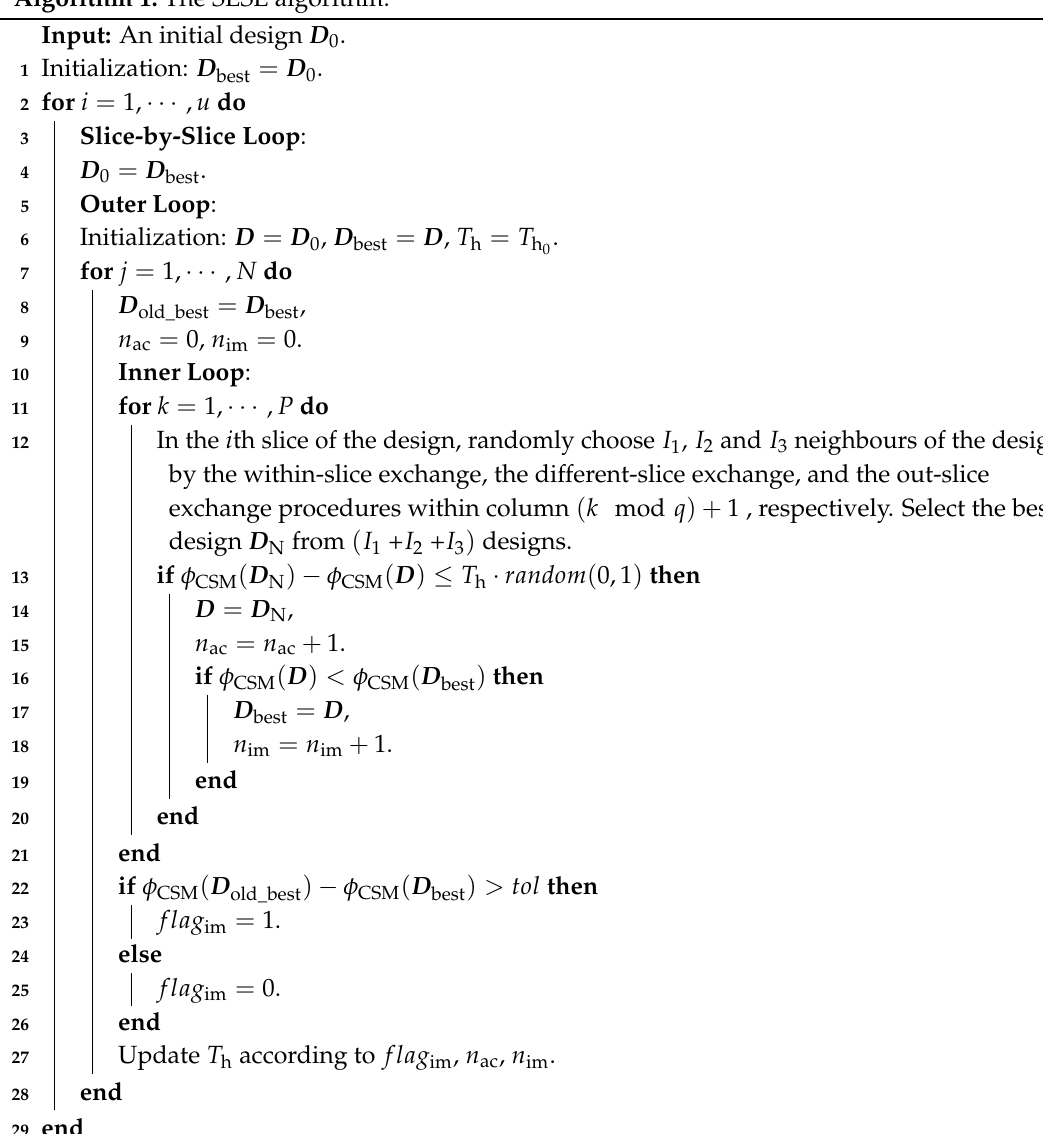
Algorithm 1: The SESE